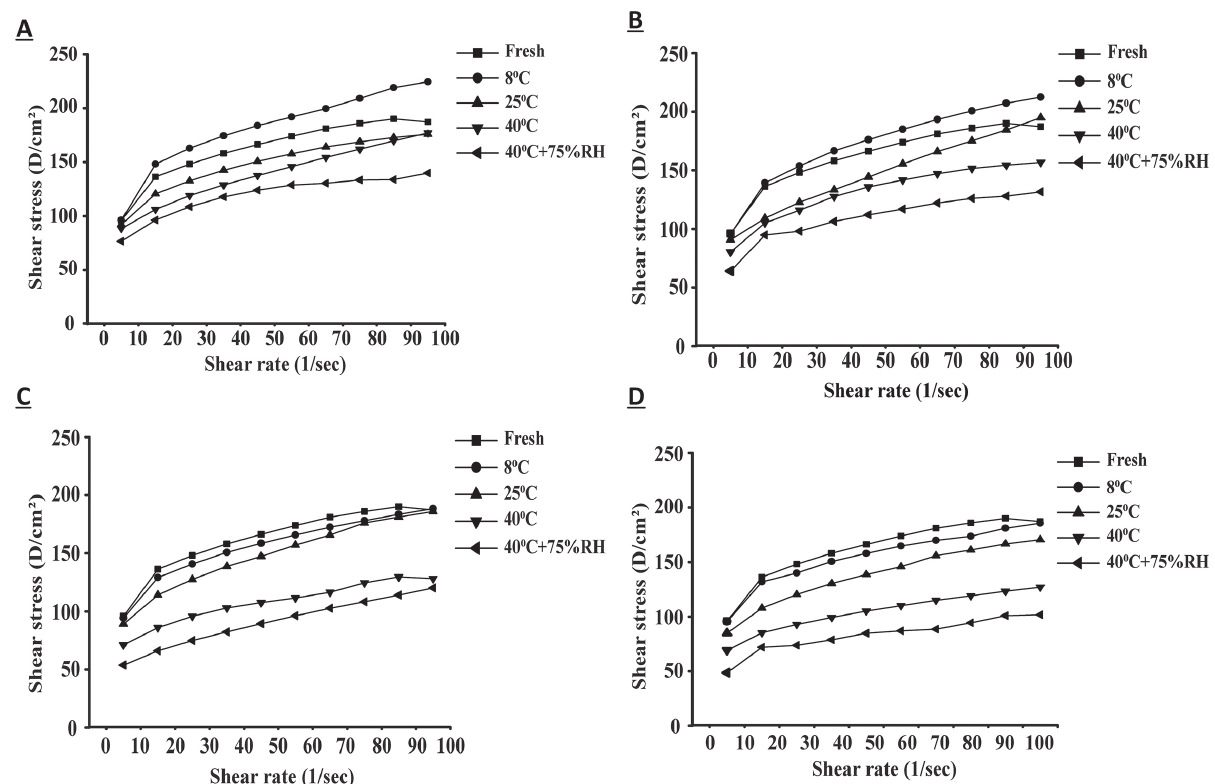
FIGURE 4 - Rheological evaluation of CT emulgel, (A) rheograms of CT emulgel at 8 °C, (B) rheograms of CT emulgel at 25 °C, (C) rheograms of CT emulgel at 40 °C, (D) r heograms of CT emulgel at 40 °C+75%